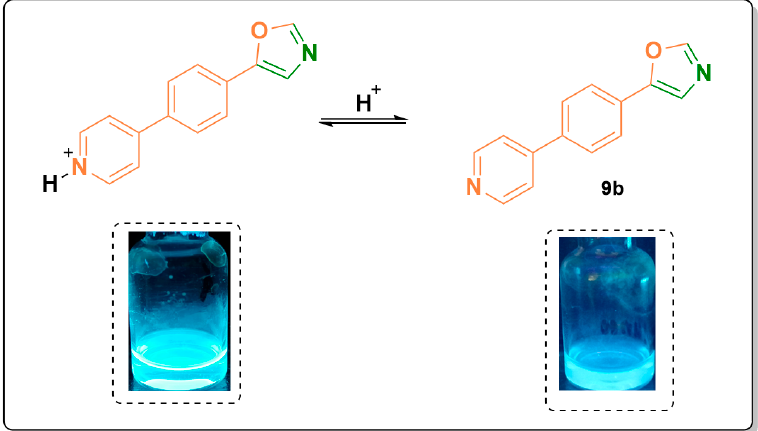
Figure 3. Fluorescence changes studies by naked-eye of oxazole 9b in medium